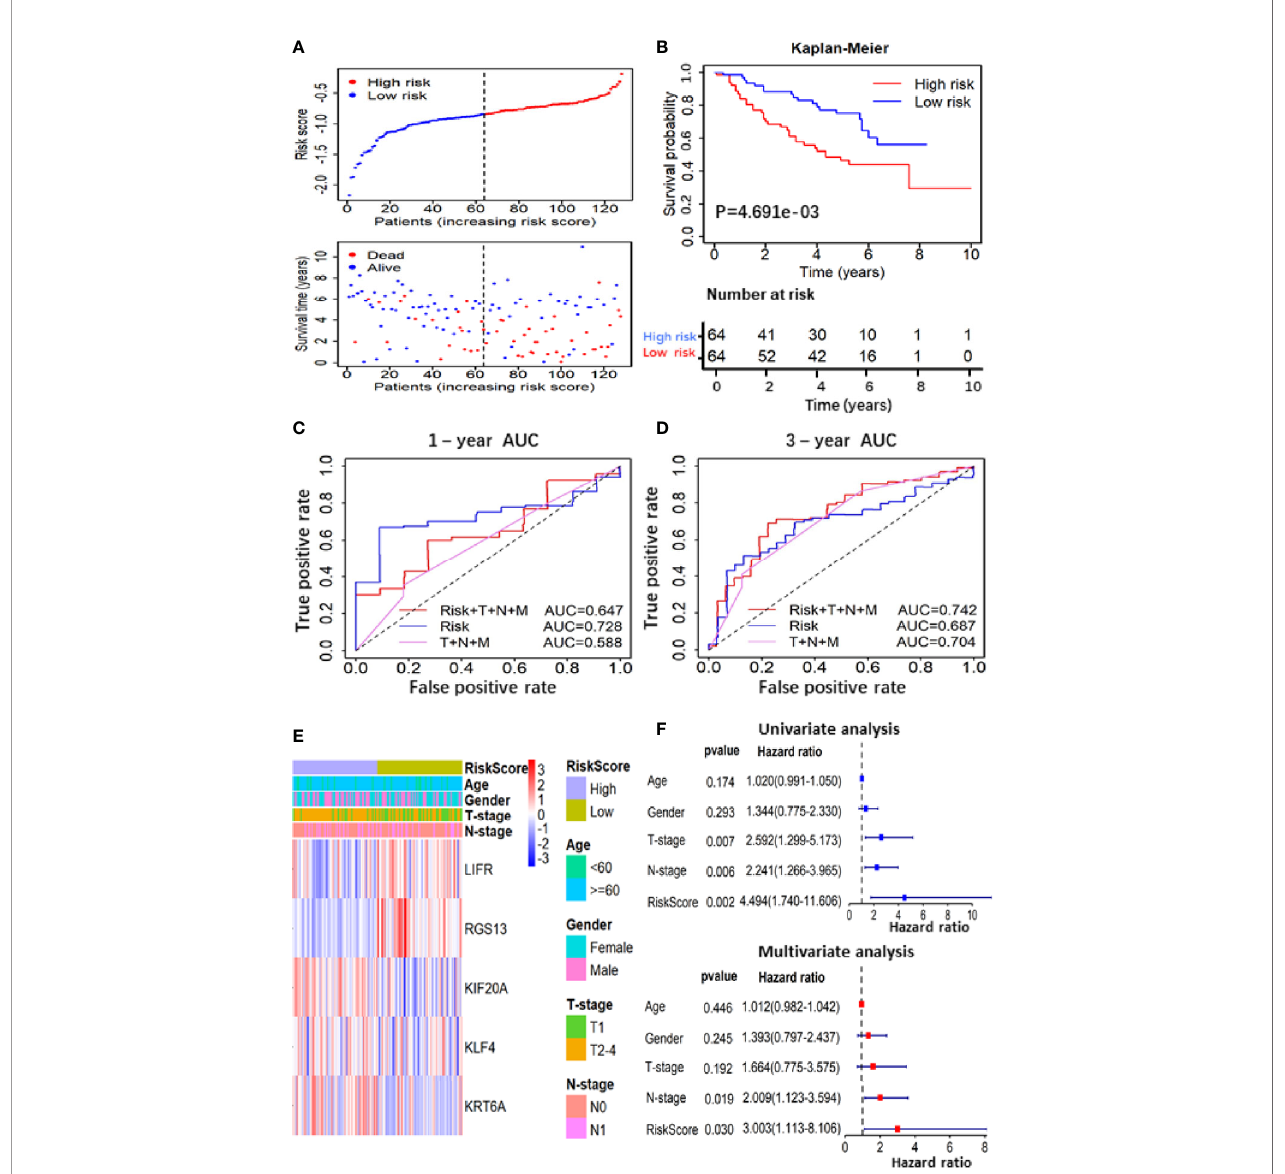
FIGURE 4 | Prognostic analysis based on of the 5 gene-RS model in GSE50081 validation cohort. (A) Patients ’ survival status distribution by the risk score; patient survival status distribution of the low-RS group and the high-RS group; (B) Kaplan – Meier curves for the low- and high-RS groups; (C , D) the receiver operating characteristic (ROC) curve validation of prognostic value by the risk score of 1 and 3 years; (E) The heatmap showed the expression levels of the 5-genes and the distribution of clinicopathological features in the low- and high-RS groups; (F) The univariate and multivariate Cox analysis for the independent 5-gene